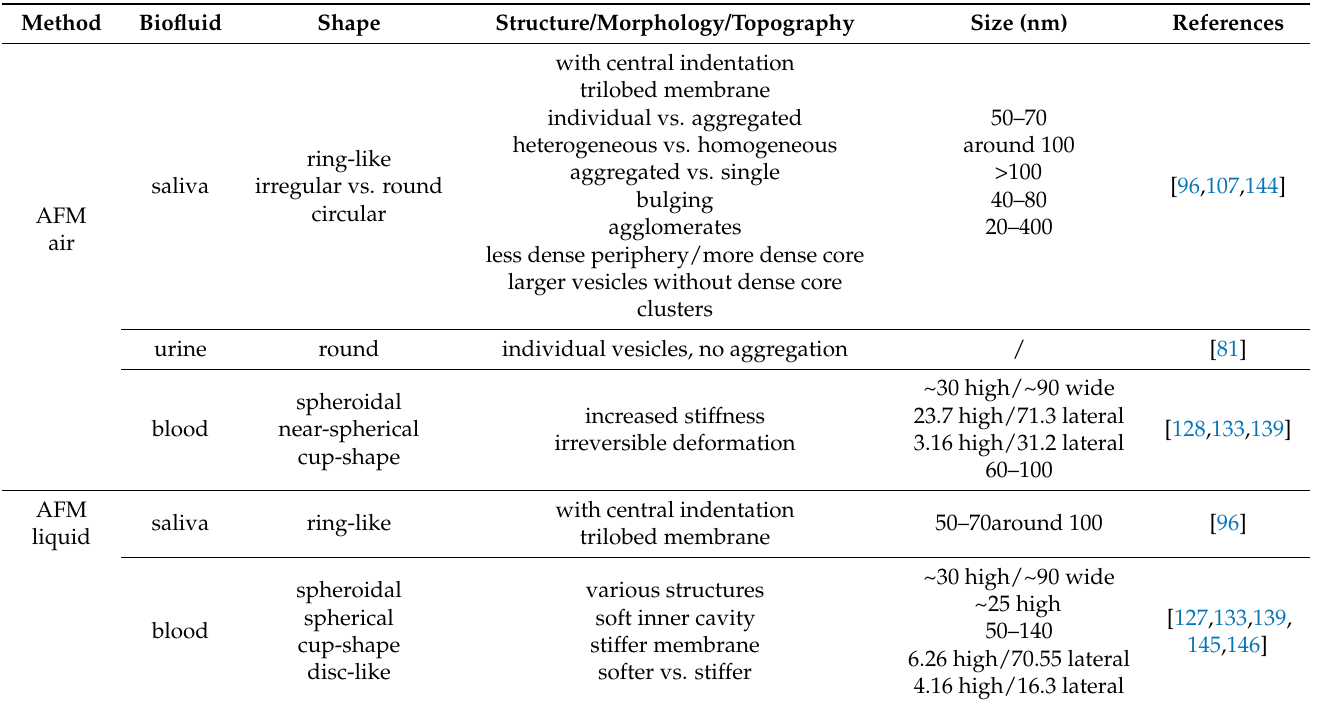
Table 2. Morphological and structural characteristics of the EVs from the human biofluids as obtained by atomic force